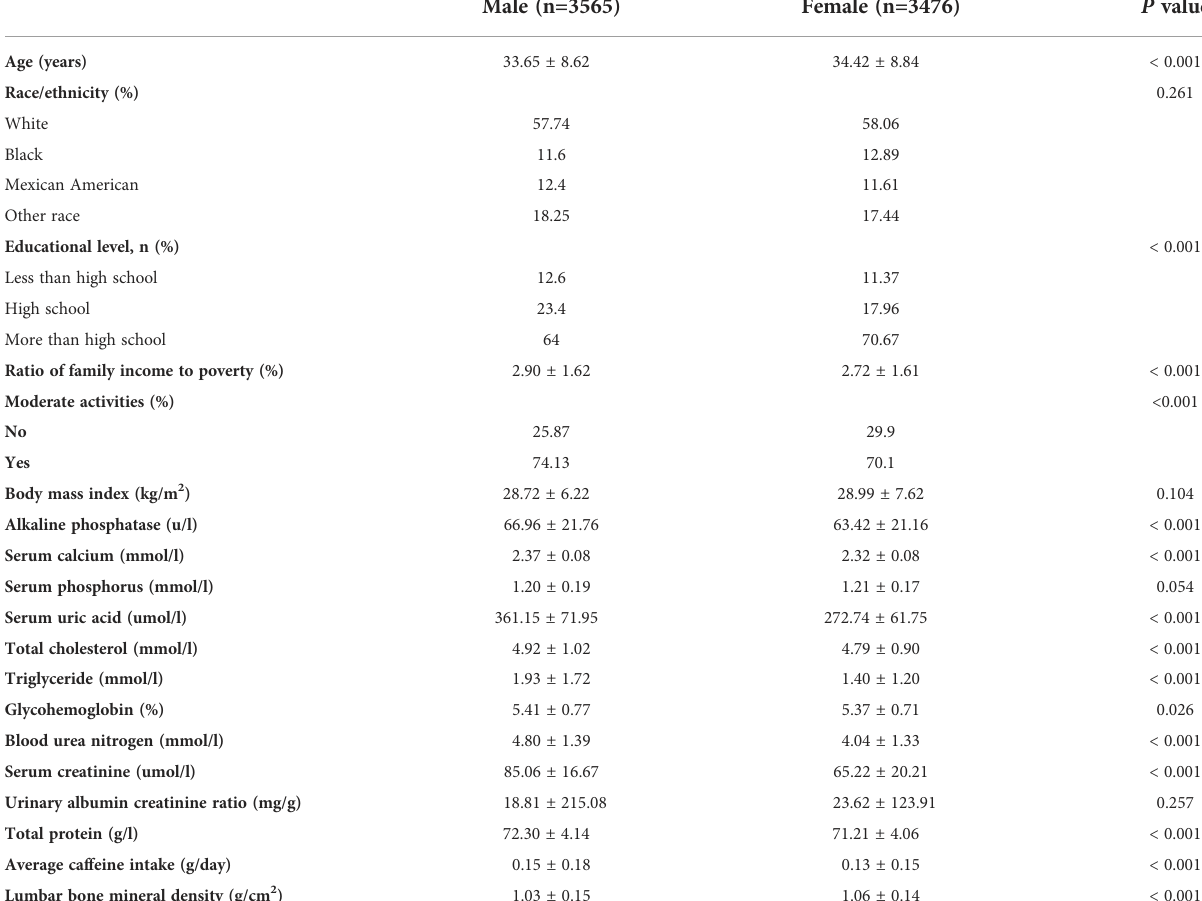
TABLE 1 Weighted characteristics of the study